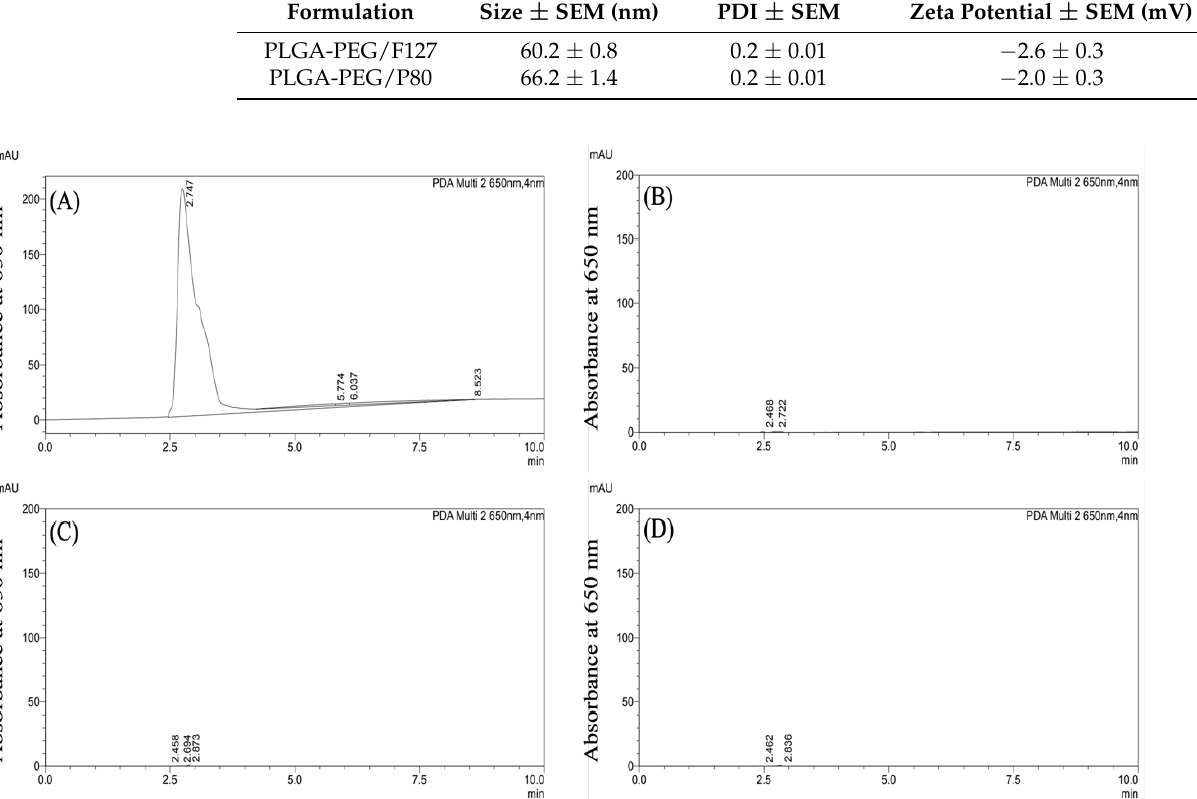
Figure 1. Representative HPLC chromatograms acquired based on absorbance at 650 nm for: ( A ) free CF647 dye at 20 nmol/mL concentration, ( B ) blank serum extracts, ( C ) serum extracts obtained from rats 4 h post injection of PLGA-PEG/F127 at a 150 mg/kg dosage, and ( D ) serum extracts obtained from rats 4 h post injection of PLGA-PEG/P80 at a 150 mg/kg dosage.